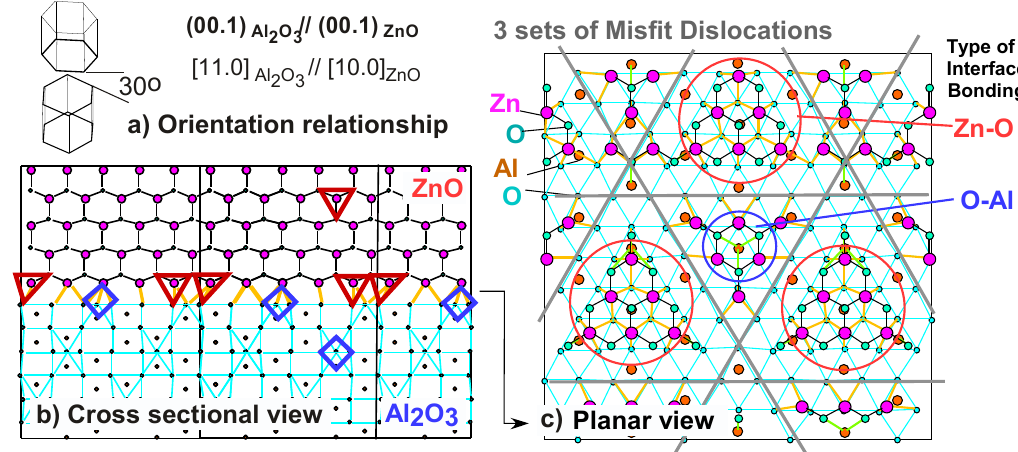
Figure 8. MD simulation results of the ZnO/Al ( b ) cross sectional view; ( c ) planar view of interface region with three sets of misfit dislocations ( b ) reprinted with permission from publisher